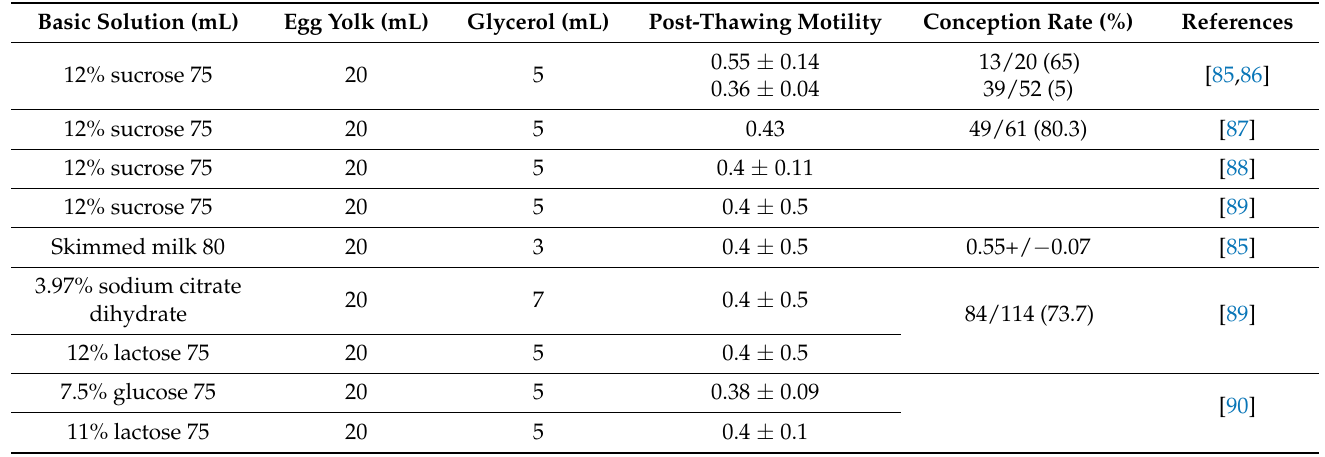
Table 3. Composition of extender for yak frozen semen